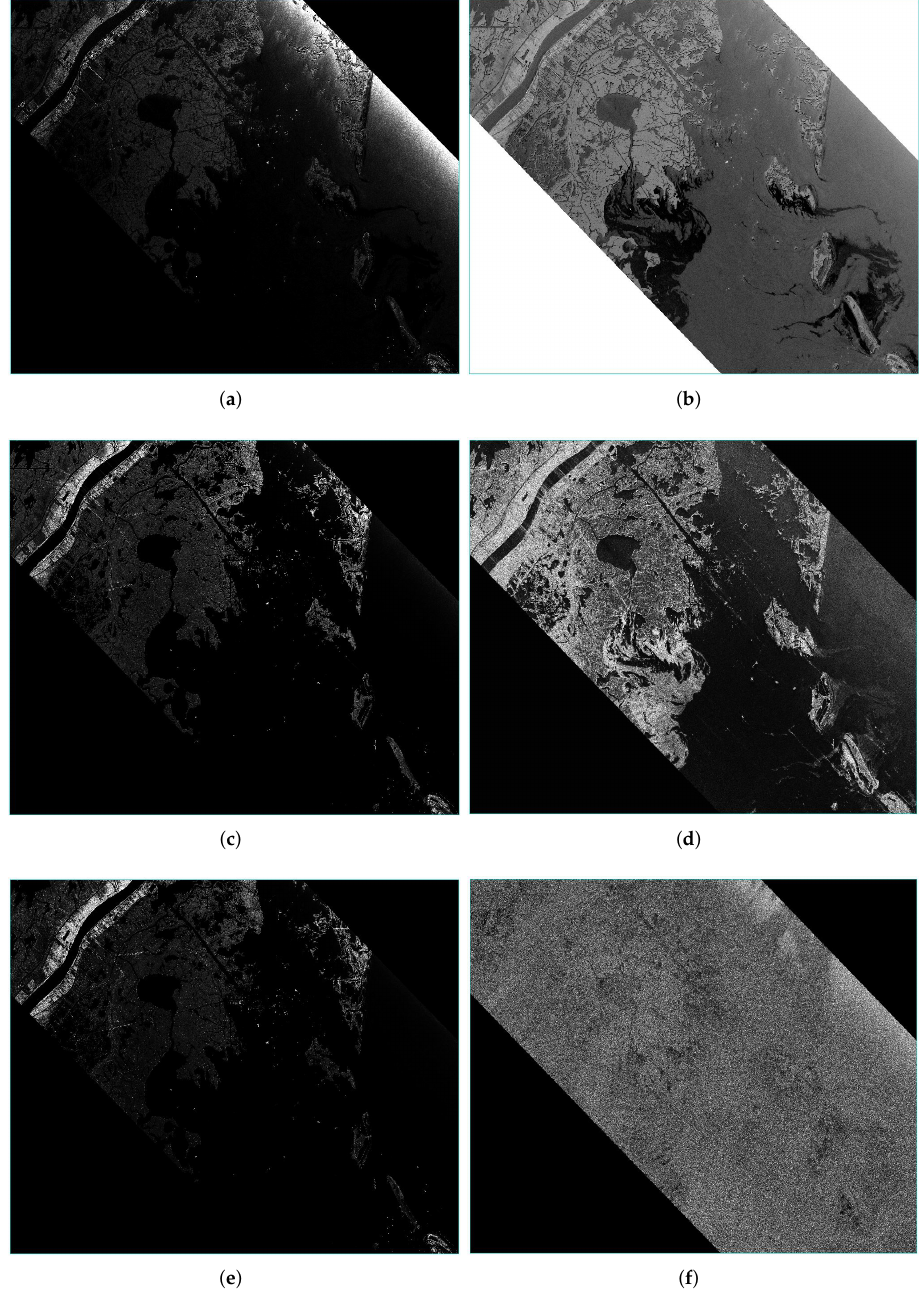
Figure 7. Comparative Analysis of Eigenvalues obtained form conventional T3, i.e., ( a ) T11, ( c ) T22, ( e ) T33 and Log Scaled T3 ( b ) T11, ( d ) T22, ( f